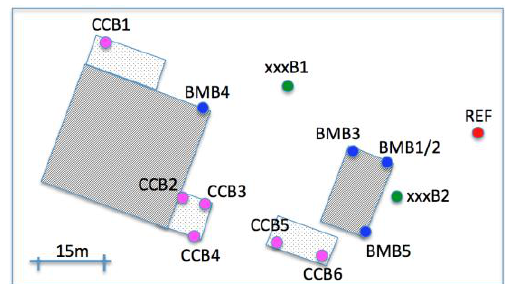
Figure 3. Scheme of the type of control points: red dot reference benchmark, blue dots benchmarks on building masonry, purple dots benchmark on concrete castings, green dots benchmarks installed at known depth (30cm, 1m, 3.5m, 5m) in a grassy field.